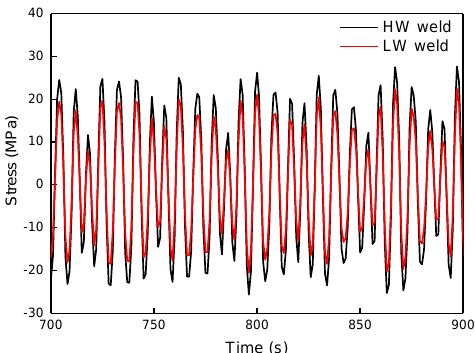
Figure 7. Stress − time curve (H S = 3.25 m, T P = 9.5 s).